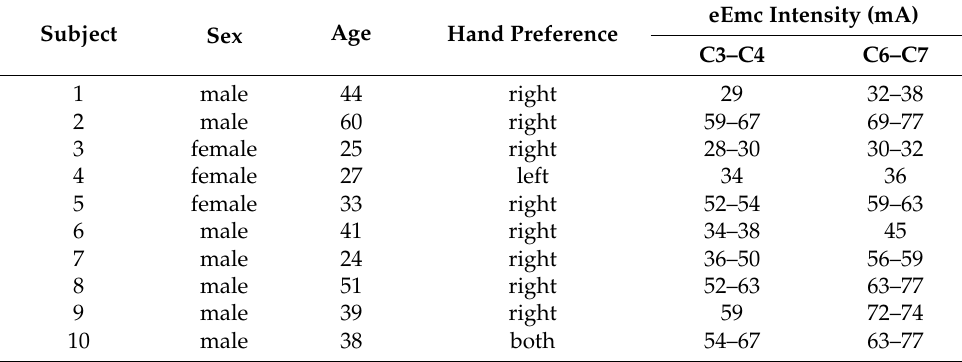
Table 1. Demographic data from the ten subjects participating in the present study. Stimulation intensities employed during high-frequency electrical enabling motor control (eEmc) are also